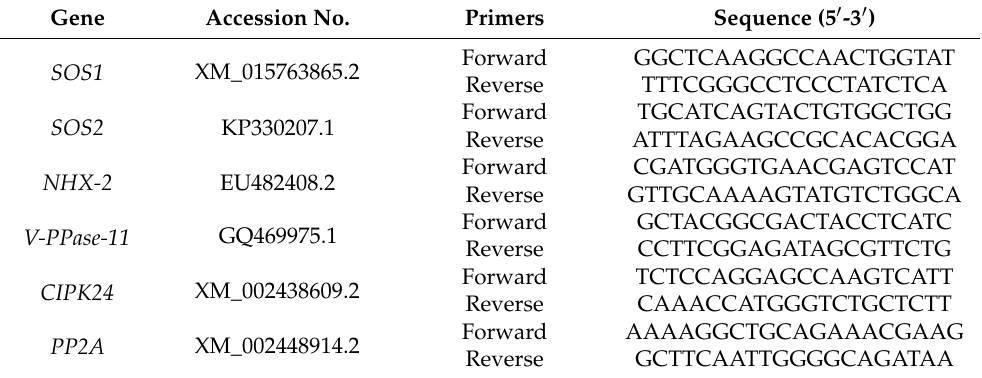
Table 1. List of